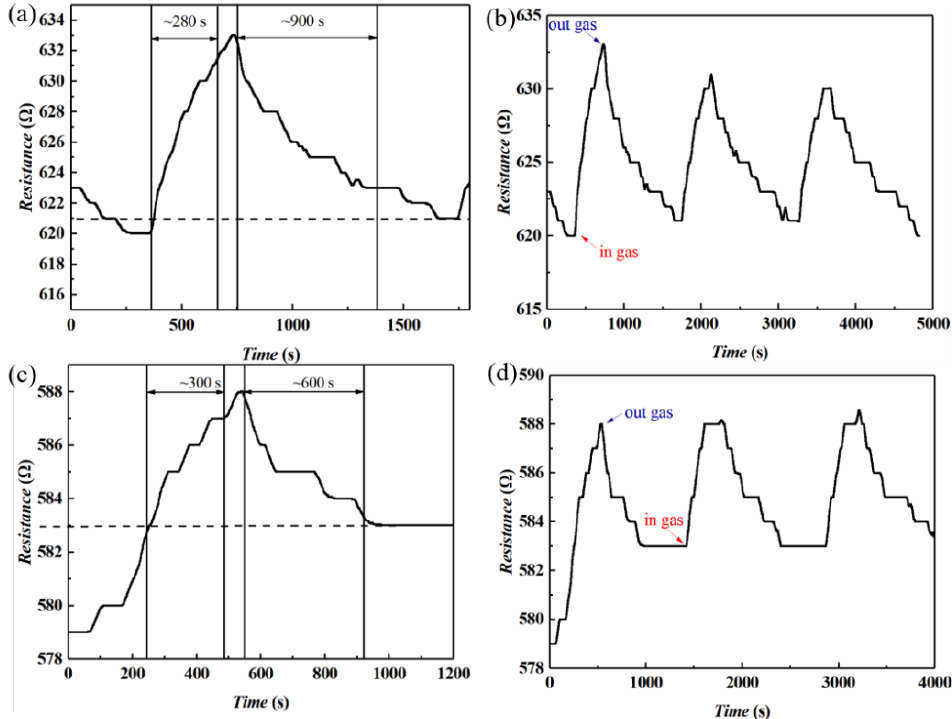
Figure 5. Gas sensitivity of graphene/WS 2 composites to 100-ppm NH 3 . ( a ) Response/recovery curve and ( b ) repeatability at 30 °C. ( c ) Response/recovery curve and ( d ) repeatability at 60 °C.